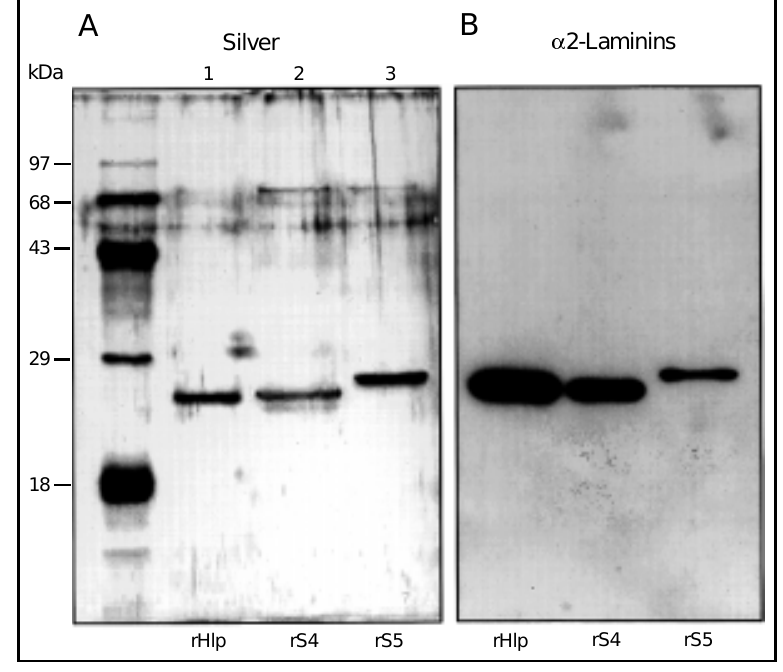
Figure 1 - Expression and laminin-binding capacity of M. leprae S4 and S5. The coding regions of the s4 and s5 genes were amplified by PCR and cloned into pTYB4 and the recombinant plasmids were used to transform E. coli ER2566 cells. The recombinant proteins were purified from crude extracts of induced cells by binding the fusion protein to a chitin affinity column followed by the release of the target protein from the column by intein-mediated self-cleavage. A , The purified rHlp (lane 1), rS4 (lane 2) and rS5 (lane 3) were analyzed by SDS-15% PAGE with silver staining. B , Binding of a 2-laminins to rHlp, rS4 and S5. Proteins were separated by SDS-15% PAGE and transferred to a nitrocellulose mem- brane. Nitrocellulose transfers were overlayed with 2.5 µg/ml biotinylated laminin and developed with the streptavidin peroxidase complex using an enhanced chemilumines- cence substrate. Molecular mass markers are indicated on the